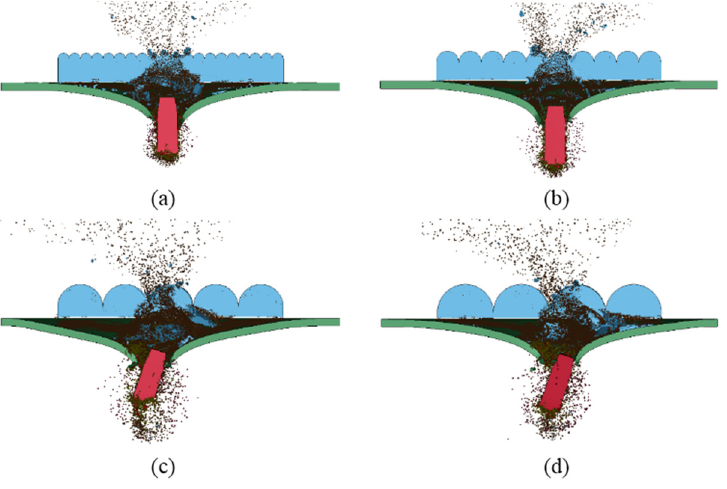
Figure 22. Damage produced when 12.7 mm API projectile penetrates three semi-cylindrical ceramic composite armors with different ξ ( d ) = 2.78.